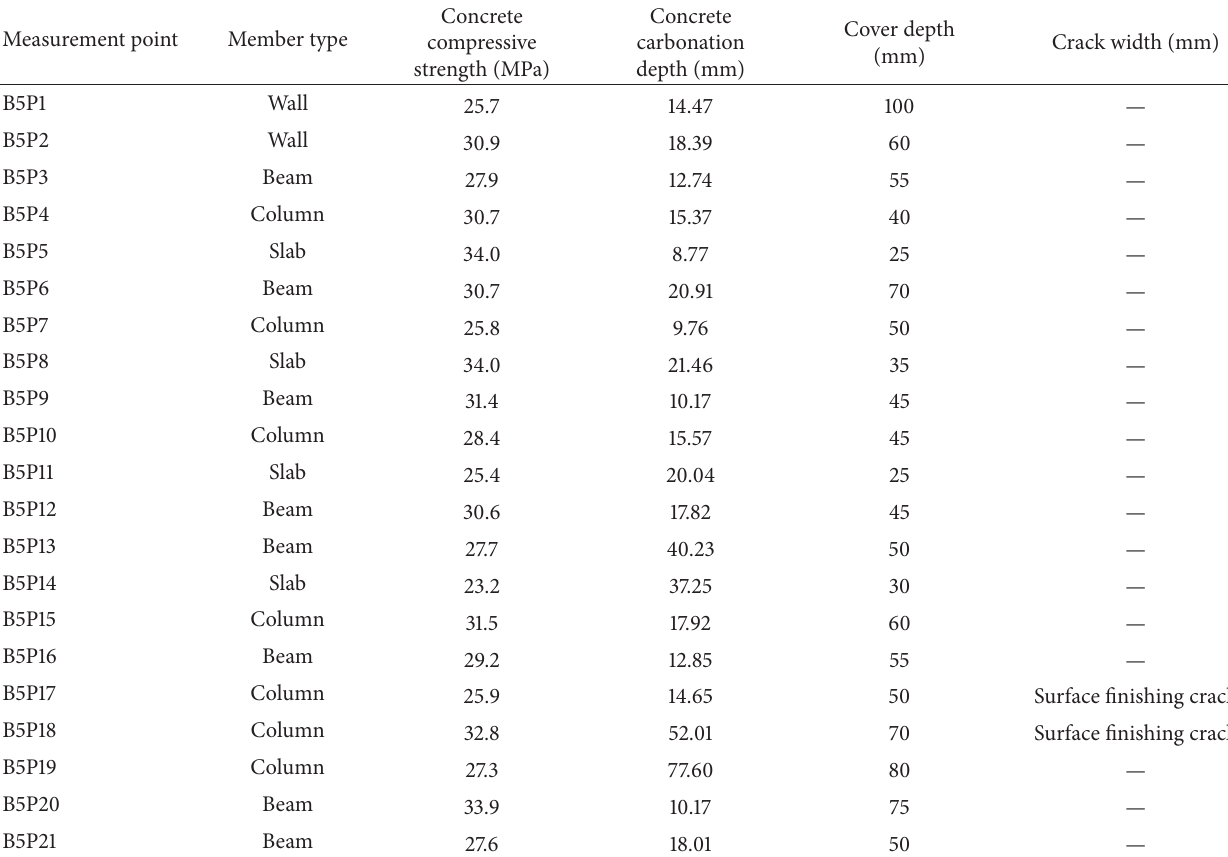
Table 7: Field investigation data (Building 5, construction completion year: